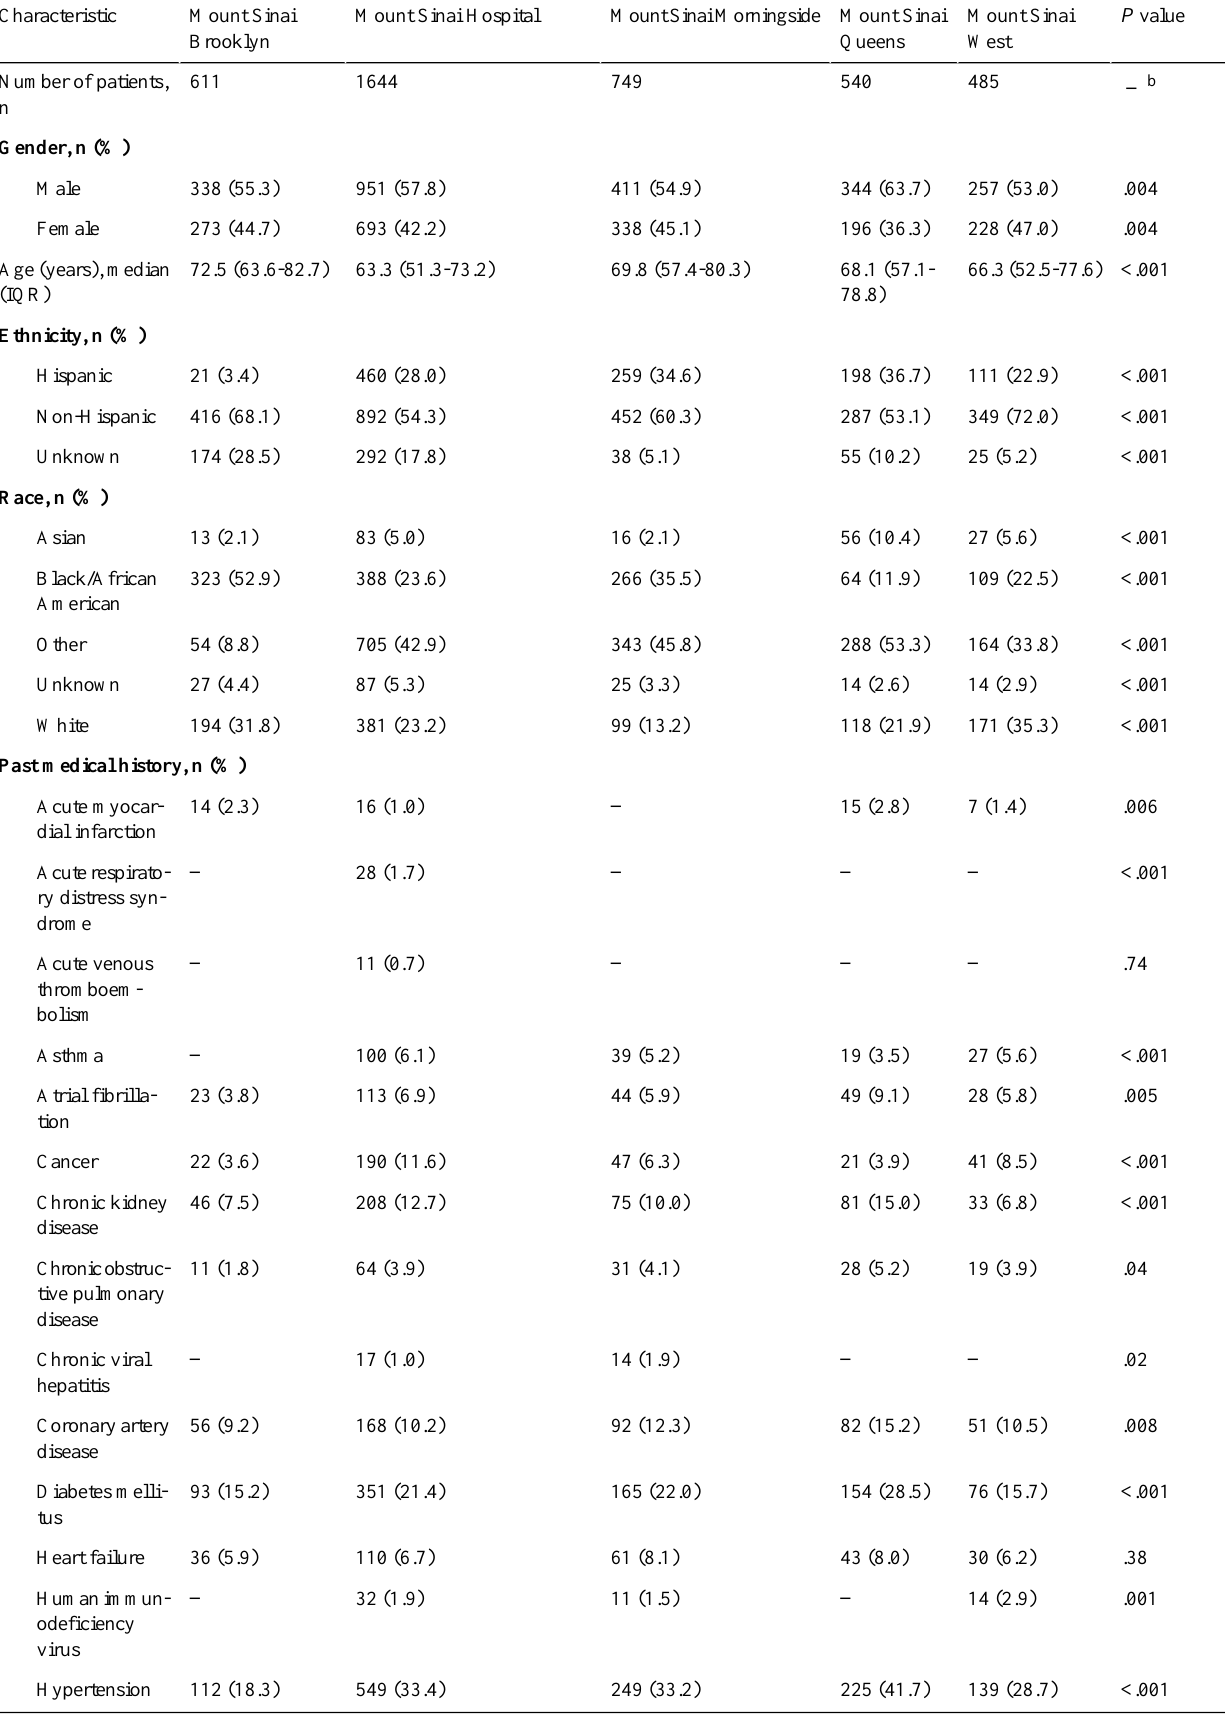
Table 1. Demographic characteristics of all hospitalized patients with COVID-19 included in this study (N=4029) a